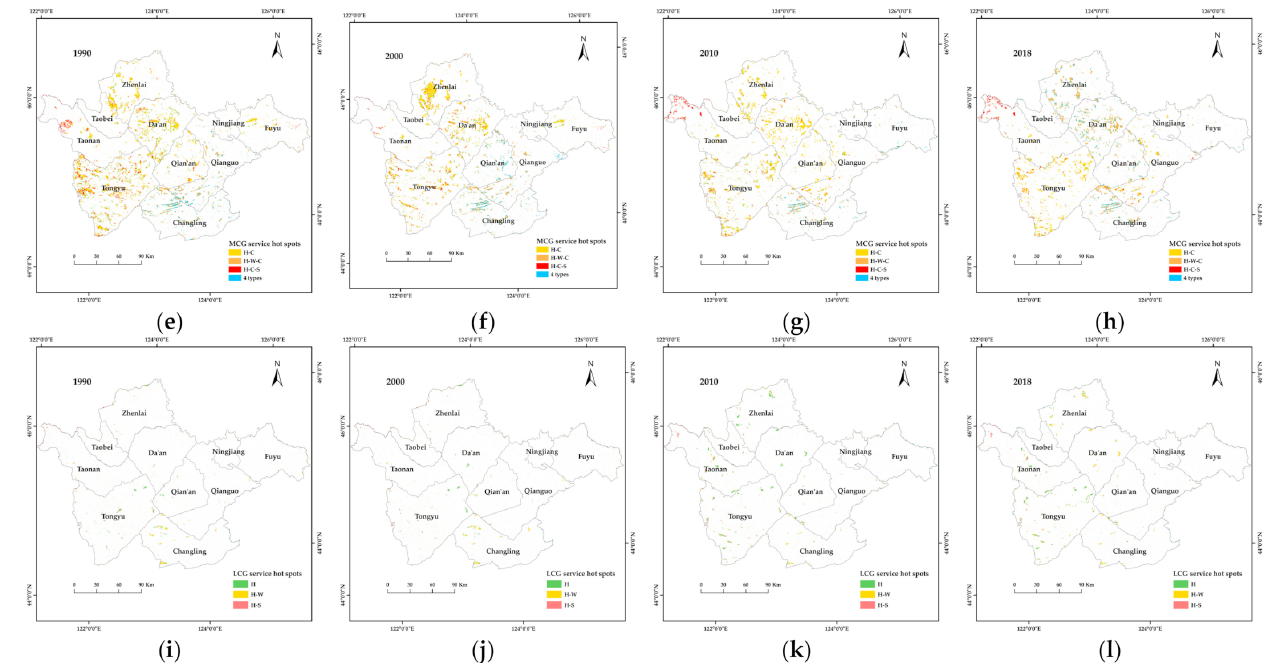
Figure 10. Distribution of ecosystem service hotspot types across grassland with different coverage during 1990–2018. C = Carbon storage; S = Soil conservation; W = Water supply; H = Habitat quality. ( a – d ), spatial distribution of service hotspots across high-cover grassland in western Jilin Province in 1990, 2000, 2010 and 2018, respectively; ( e – h ), spatial distribution of service hotspots across medium-cover grassland in western Jilin Province in 1990, 2000, 2010 and 2018, respectively; ( i – l ), spatial distribution of service hotspots across low-cover grassland in western Jilin Province in 1990, 2000, 2010 and 2018,